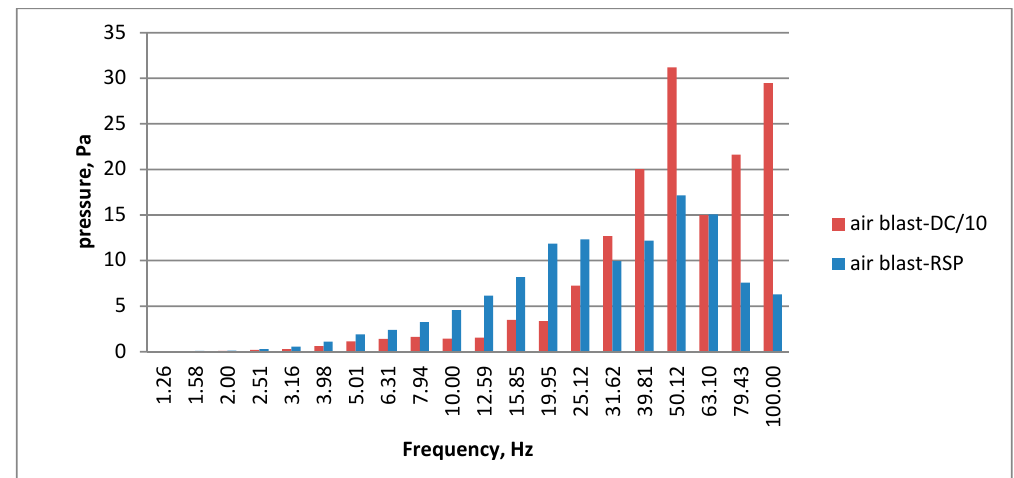
Figure 11. Result of the third octave analysis for the horizontal y component at station 1.